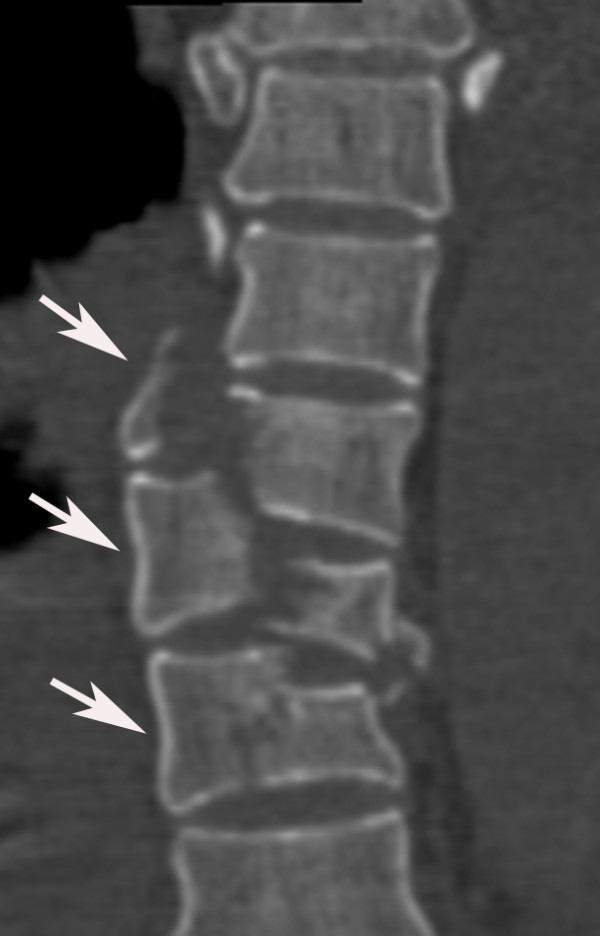
Reformatted coronal image of a 51-year-old female patient who had crush trauma as a result of an earthquake shows an oblique fracture from T5 through T7 and form type C3 lesions.